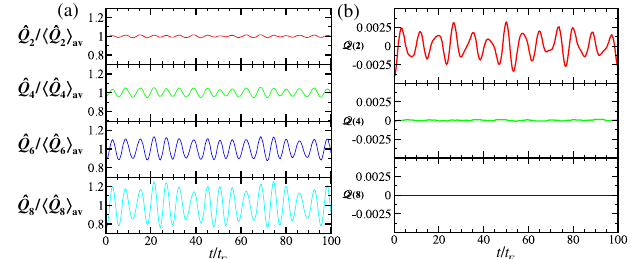
FIG. 11. (a) The post-quench time evolution of the same normalized Lieb-Liniger charges shown in Fig. 2 of the main text but at times t < 100 t F . (b) The post-quench time evolution of the sequence of effective charges, Q ð N Q Þ − a 0 I ¼ shown in Fig. 2 for N Q ¼ 2 ; 4 , and 8 for the same range of